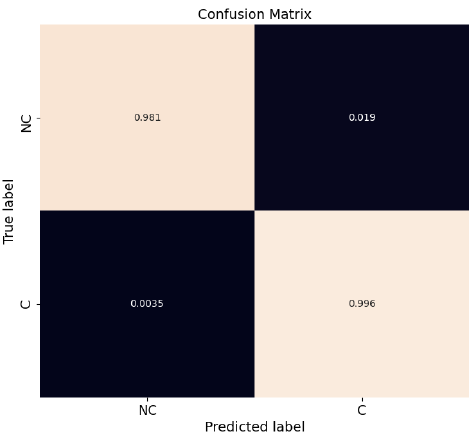
Figure 4. Confusion matrix for RF classification for test set (recordings #19 to #29).